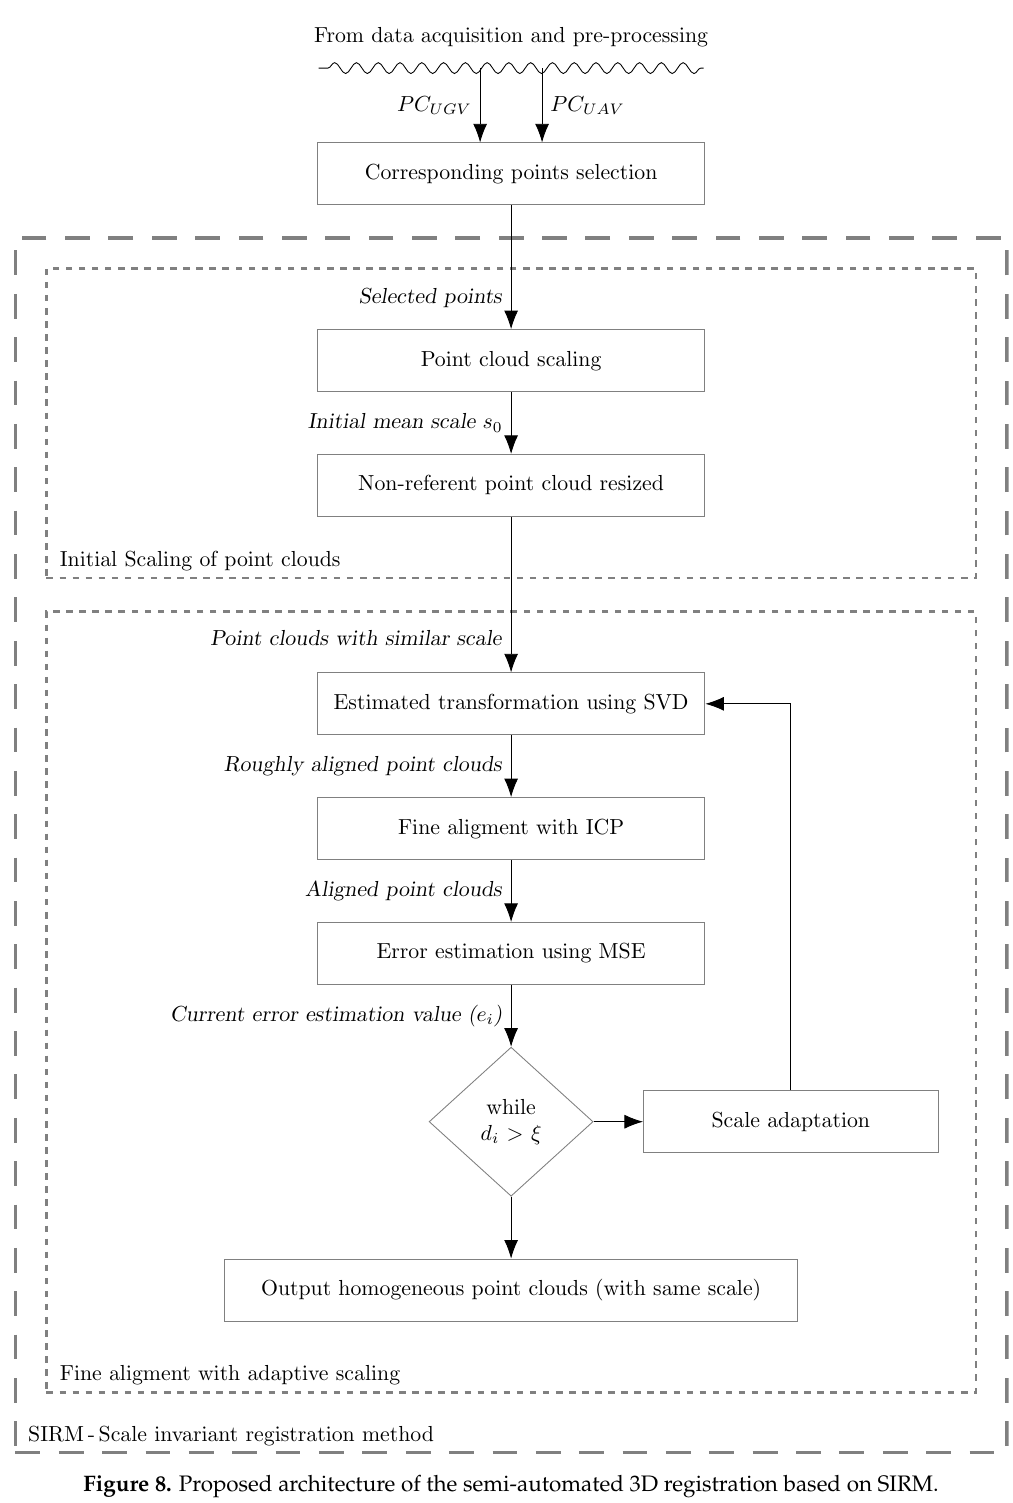
Figure 8. Proposed architecture of the semi-automated 3D registration based on